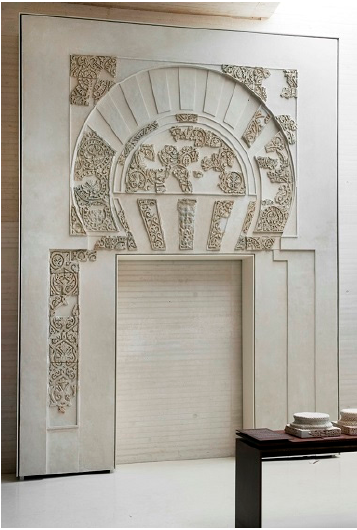
Figure 6. D ā r al-Mulk . Decoration of the interior doors. (Photo M. Pijuán © Conjunto Arqueológico de Madinat al-Zahra).